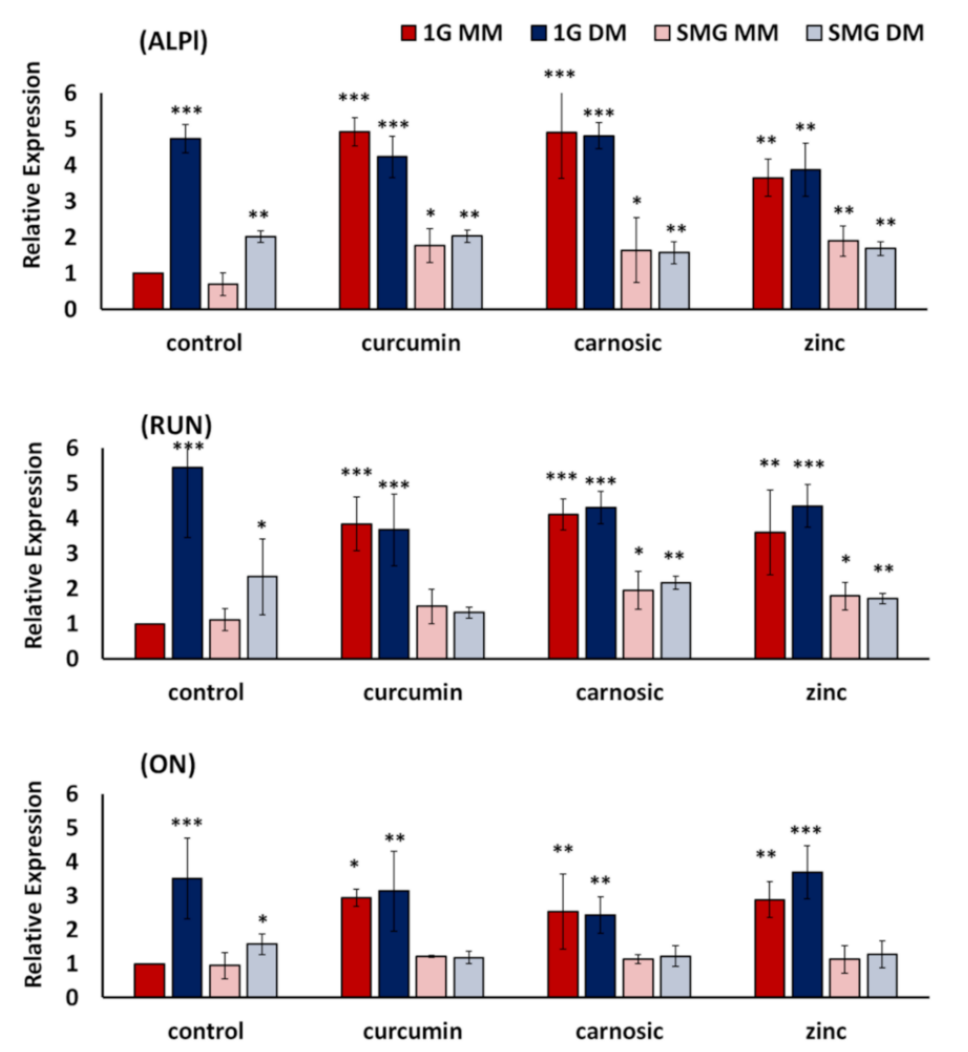
Figure 3. Effects of nutraceuticals on the expression of osteogenic marker genes ALPl, RUN, and ON. 7F2 cells were cultured for six days in 1G and SMG, respectively, in non-osteogenic maintenance media (MM) and osteogenic differentiation media (DM). Gene expression was analyzed by real- time PCR and normalized to the levels of a housekeeping gene (GAPDH), with 1G MM as control. The expression of each gene to internal control is presented as fold-change expression for each transcript, with control as 1-fold expression. For details, see Materials and Methods. Nutraceutical concentrations were 7.5 µ M curcumin, 10 µ M carnosic acid, 50 µ M zinc. Values are Means +/ − SD of n = 3. Versus 1G-MM-Control, Asterisk (*) p < 0.05, (**) p < 0.01, (***) p < 0.001. The results reflect means ± SD from three independent experiments ( n = 3 biological